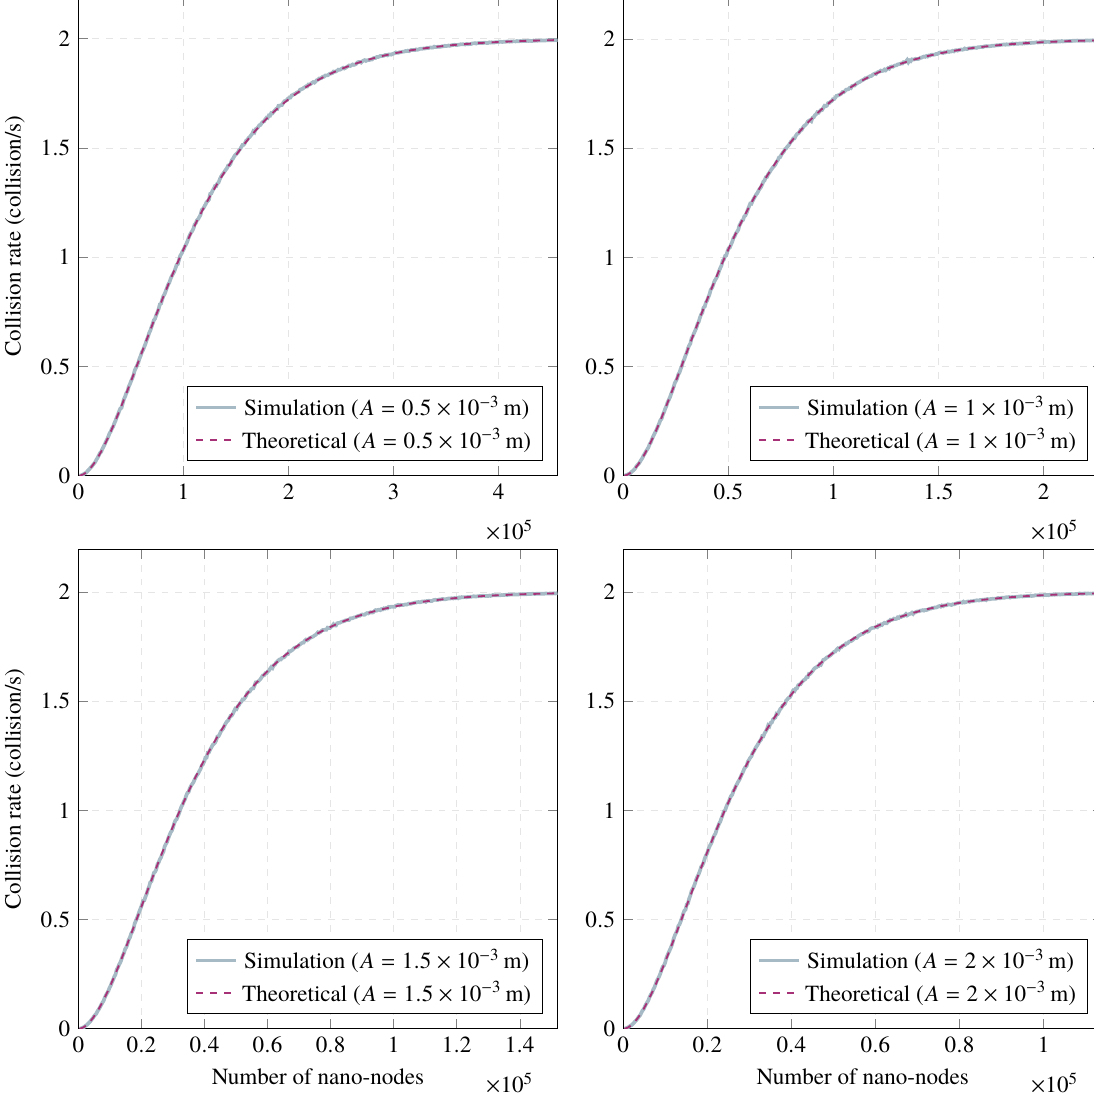
Figure 9. Impact of the length of the coverage area on the network collision rate for A = 1 × 10 − 3 m, f = 1Hz, v = 0.24m / s, T = 60s, σ = 2, and t f =